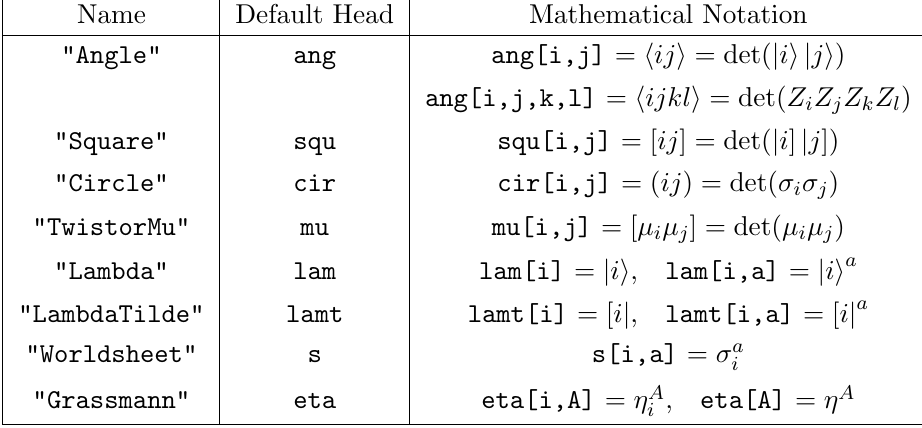
Table 3 . The default heads reserved by treeamps4dJAF for analytical computations. See section 2 for de(cid:12)nitions and